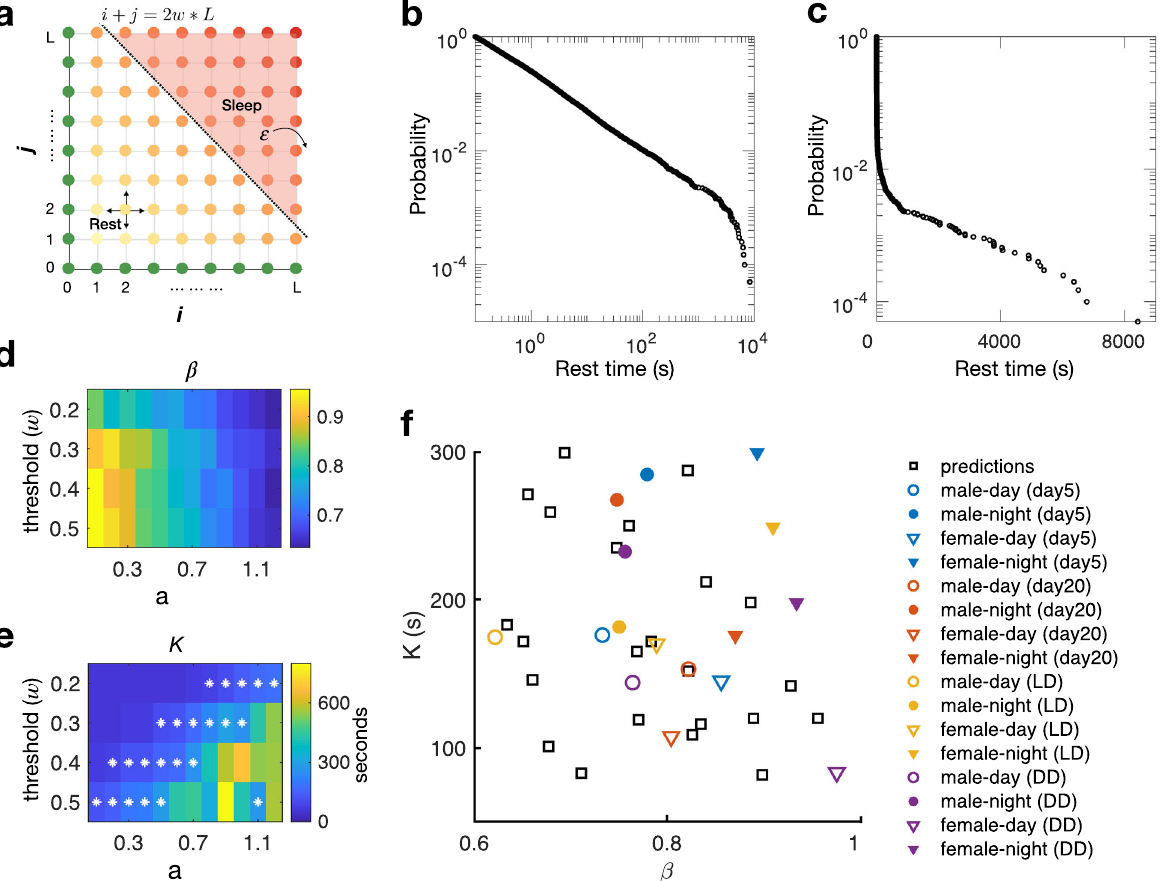
Fig. 6 Mathematical model of sleep pattern. a The schematic of the model. Assume each hemisphere has L ( L = 50 in our model) possible states when the fl y is resting, the quietness of the hemisphere increases from state 1 to state L . The color of each state in the 2D space indicated how quiet the whole brain is. Fly would get back to motion if any of the hemispheres moves to state 0 (the green dots on the boundaries). If the brain state crosses the threshold line (black dotted line), the fl y would enter the sleep phase (red dots) and would wake up with a constant rate ε . b – c Simulated results of the model. Statistics of the time the walker takes to get out of the L × L rest state space is similar to the distribution of the fl y ’ s rest time observed experimentally. d The active index generated by the model as a function of the parameters in the model. e The sleep latency generated by the model as a function of the parameters in the model. Asterisk: parameters that generated a sleep latency in the range of 80 – 300 s. f Comparison of the active index and sleep latency between those generated from the model with parameters marked by asterisks in ( e ) and those from the real data. Black squares represent the predicted values from the model. The experimental data is shown as the mean values of the fl ies from 4 scenarios (in 1D chamber with LD condition at day 5, in 1D chamber with LD condition at day 20, in 2D chamber with LD at day 5, and in 2D chamber with DD at day 5). Hollow circle, male in the light phase; fi lled circle, male in the dark phase; hollow triangle, female in the light phase; fi lled triangle, female in the dark